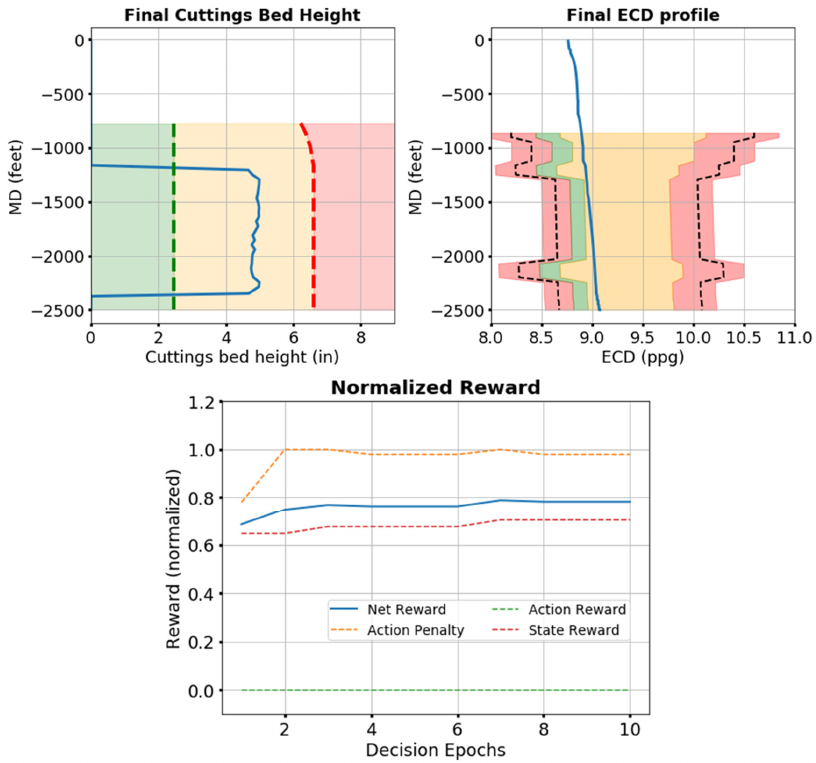
Figure 21. Predicted final system state and rewards after implementing action sequence four. Energies 2022 , 15 , x FOR PEER REVIEW The output of the execution of action sequence five is depicted in Figure 22. This sequence would result in a substantially reduced bed height (under 3.5 inches) and an ECD value very close to the desired region. The net and the state reward values for this case are 0.82 and 0.76, respectively. In this case, both the flow rate and the RPM are increased, from 833 to 1500 GPM and 83 to 150 RPM, respectively.